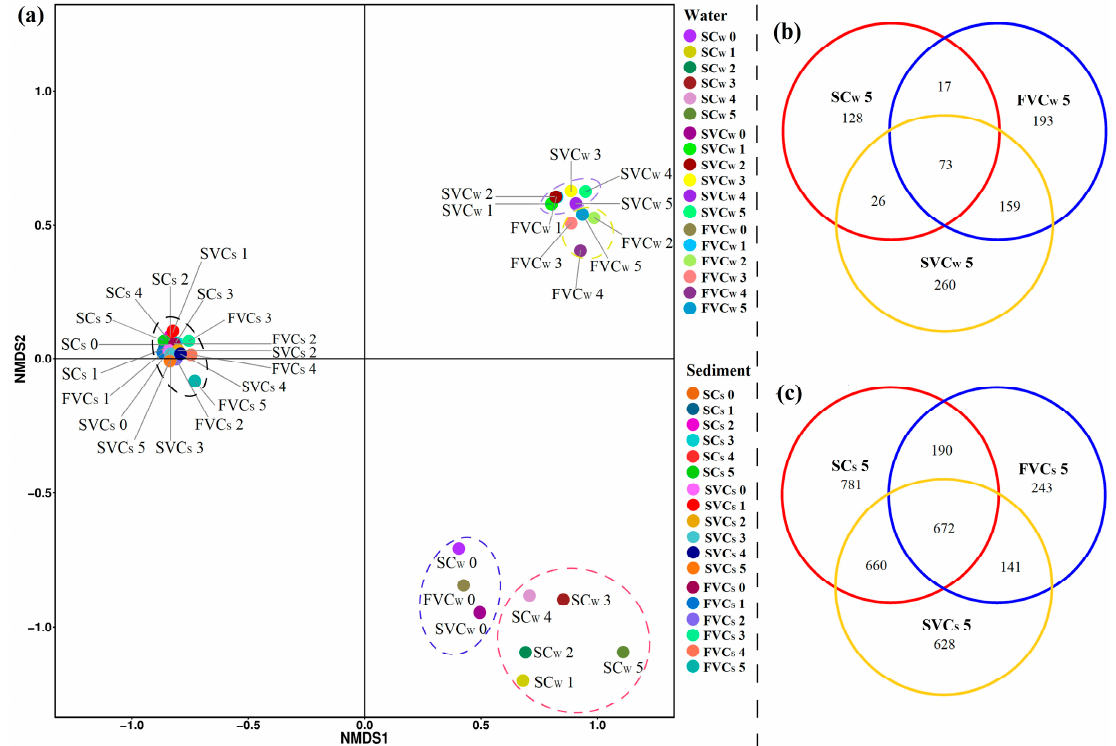
Figure 6. ( a ) Non-metric multidimensional scaling (NMDS) ordination visualization of the bacterial communities in the water and sediment along the timescale (week 0–5). ( b ) Venn diagram of water samples at 5 weeks. ( c ) Venn diagram of sediment samples at 5 weeks. The detailing taxon shared were shown in Table S3. SC: static control, SVC: slow velocity condition, FVC: fast velocity condition. The subscript S denotes the sediment and W denotes the water.